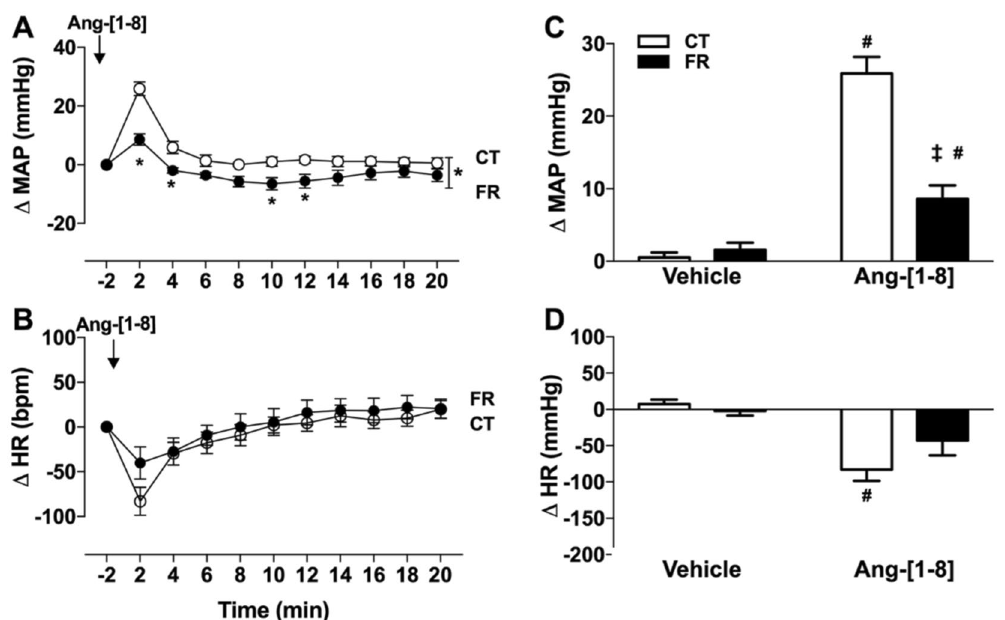
Figure 3. Effect of FR on MAP and HR responses to infusion of Ang-[1–8]. Shown are the changes ( A , B ) or maximum change from baseline ( C , D ) in MAP ( A , C ) and HR ( B , D ) after vehicle or Ang-[1–8] infusion in CT (open circle) and FR (closed circle) female rats (n = 8/group). Basal MAP (mm Hg): CT, 117 ± 5.0 vs. FR, 114 ± 5.0; Basal HR (bpm): CT, 386 ± 14 vs. * FR, 309 ± 18. * P < 0.001 vs. CT by two-way ANOVA and Bonferroni post-hoc test (time; diet); # P < 0.01 vs. vehicle, same animal group by unpaired Student’s t -test and ‡ p < 0.001 vs. CT, same treatment, by two-way ANOVA and Bonferroni post-hoc test (drug; diet). Values are expressed as the mean ±